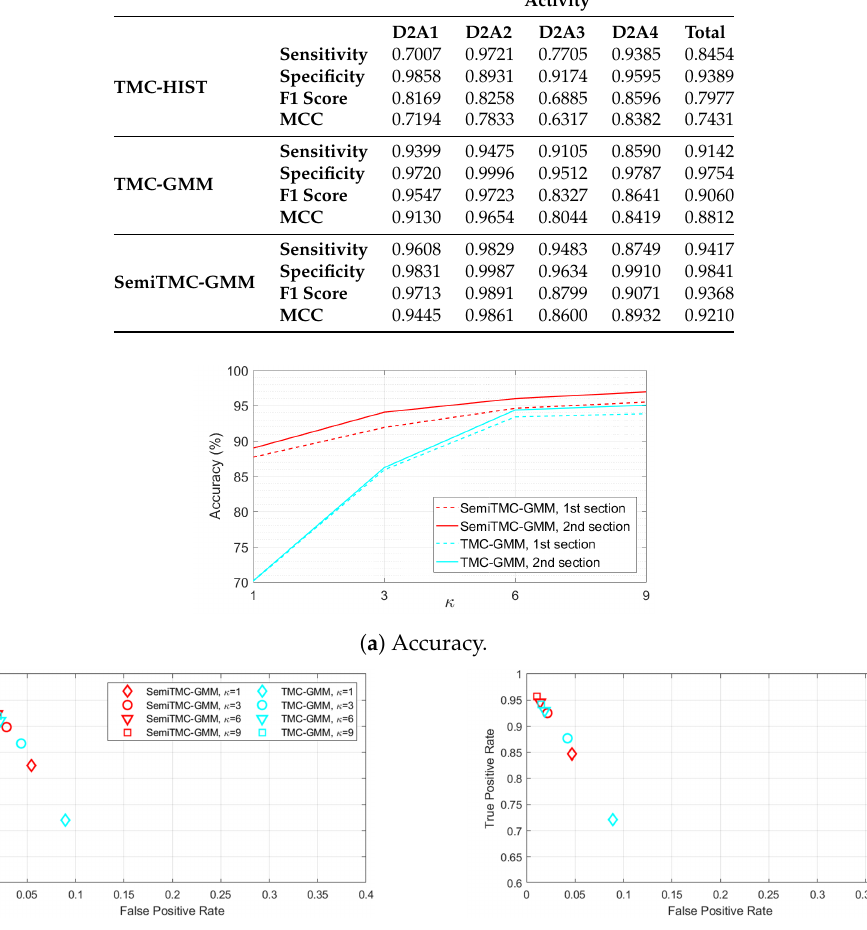
Table 2. The sensitivity, specificity, F1 score, MCC value of the batch mode recognition, for each activity of LMFIMU dataset, using the sensor placed on right shoe. Up : TMC-HIST; middle : TMC-GMM when κ = 9; and down : SemiTMC-GMM when κ = 9.